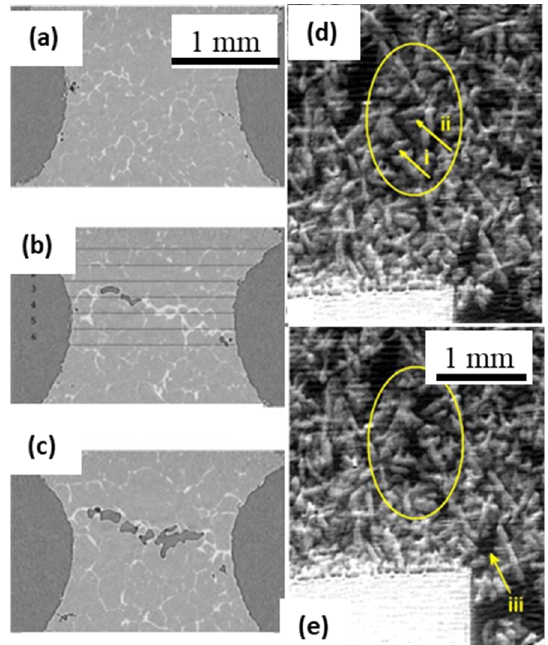
Figure 8. ( a – c ) 3D reconstructed slices showing the evolution of a hot-tear during tensile deformation of a semi-solid Al-Cu alloy specimen (after Terzi et al. [117]). ( d , e ) In situ radiographic observations showing direct evidence for Reynolds’ dilatancy in an equiaxed dendritic mush. In the circled region, an initially compacted crystal assembly dilates during deformation under a compressive load (after Gourlay et al. [119]) Permitted for reuse from respective publishers.